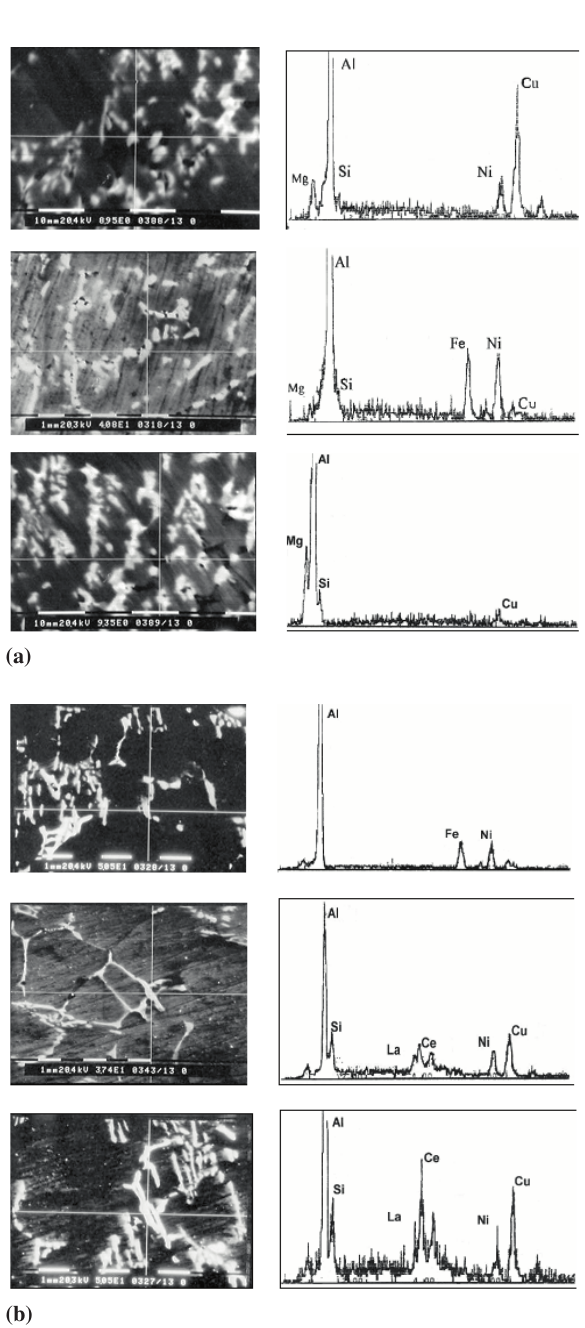
Figure 1. EDS spectra of phases in alloy 1 (a) and alloy 3